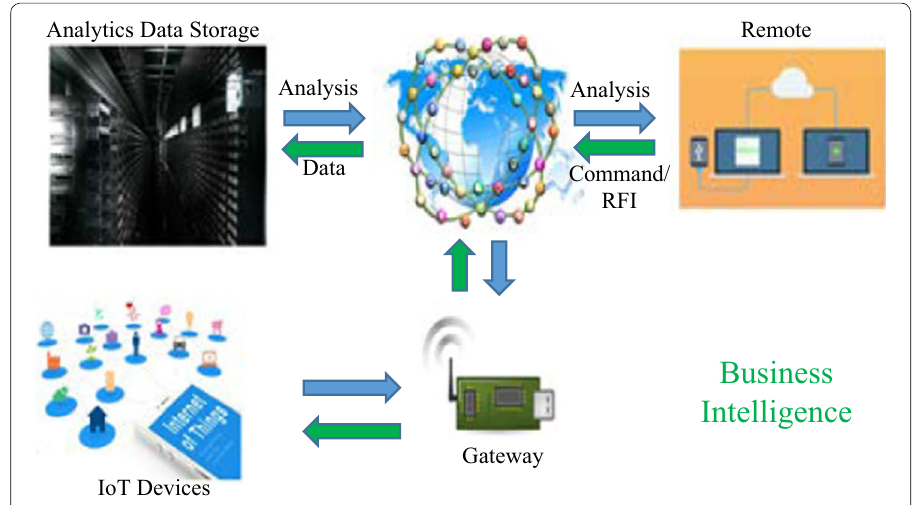
Fig. 1 General architecture of